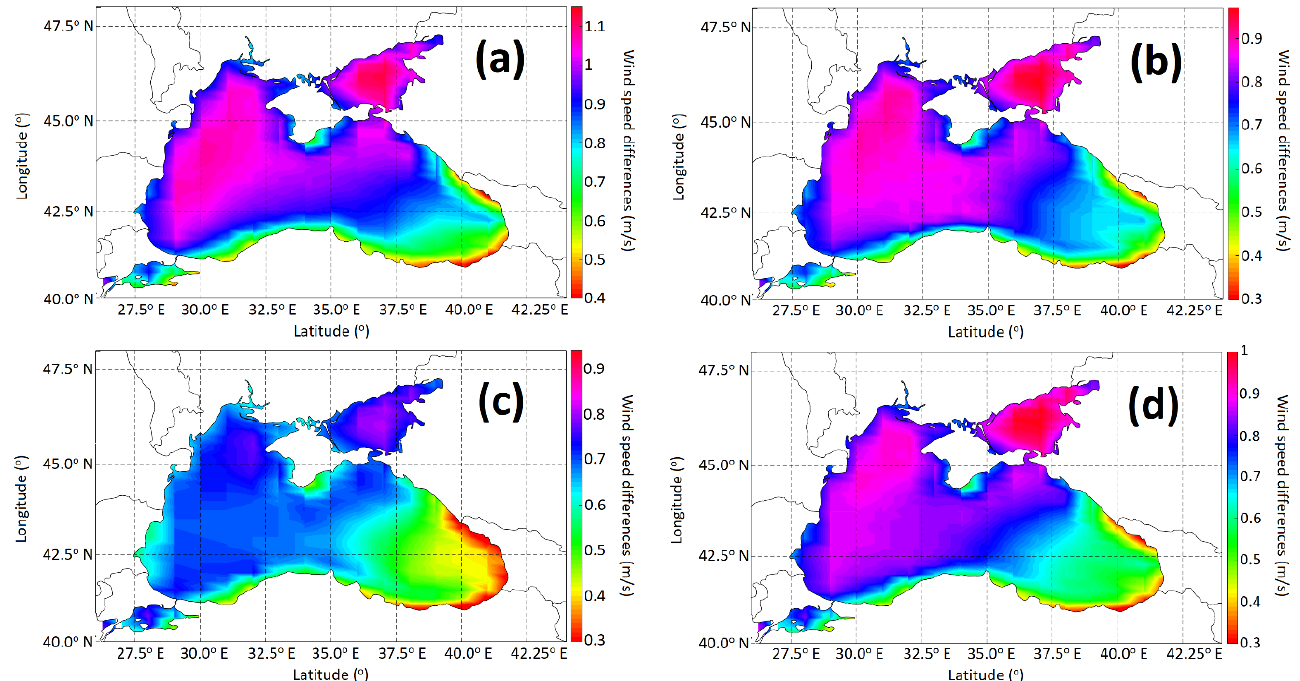
Figure 5. Seasonal differences (in m/s) expected between the wind conditions associated with the reference heights of 100 and 500 m (U500 minus U100). ( a ) winter; ( b ) spring; ( c ) summer; ( d ) au- tumn.